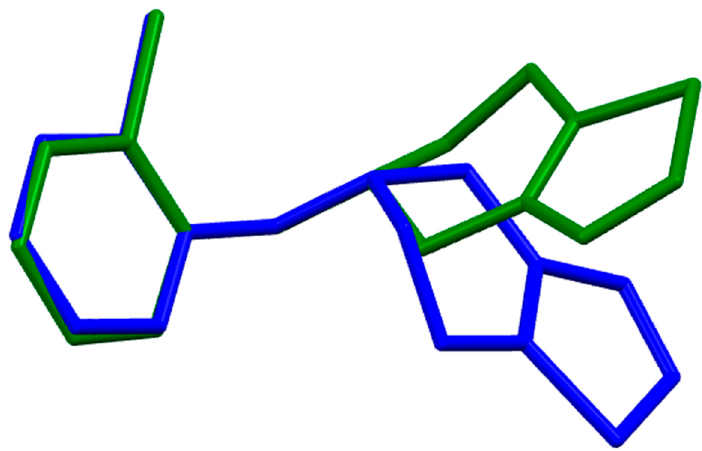
Figure 2. Molecular superimposition of the Becke3LYP optimized structure of ticlopidine (green) and ticlopidine from the co-crystal with cytochrome P450 2B4, PDB.2KW4 (blue). For simplicity, the hydrogen atoms are not shown.